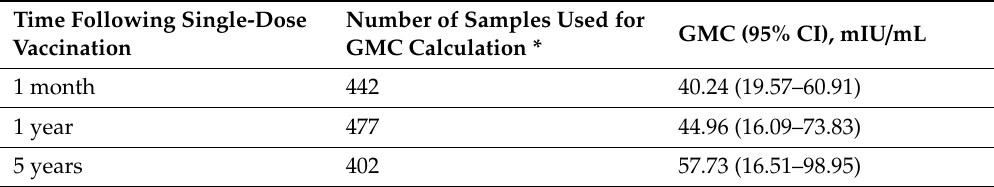
Table 4. Serum anti-HAV antibody GMCs in samples from vaccinated children collected one month, one year and five years following single-dose